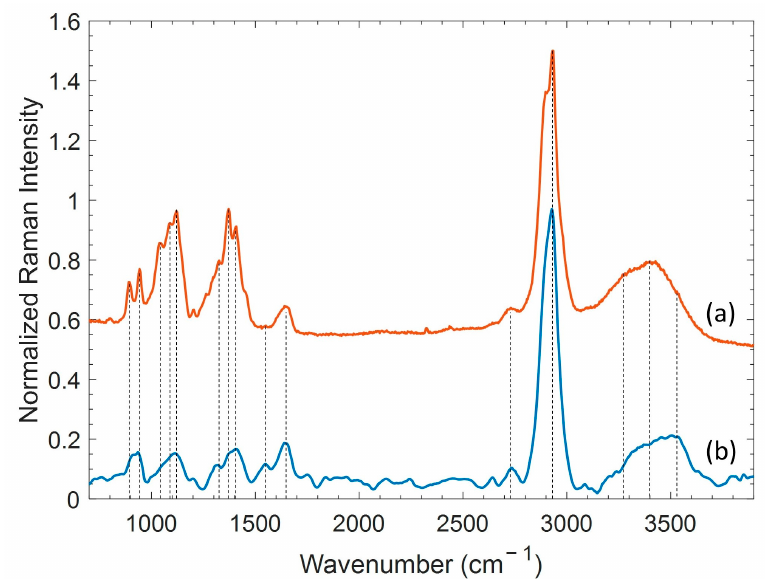
Figure 2. Comparison of Raman spectrum of HA powder (a) and SERS spectrum of HA solution (b). The spectra were normalized and shifted.